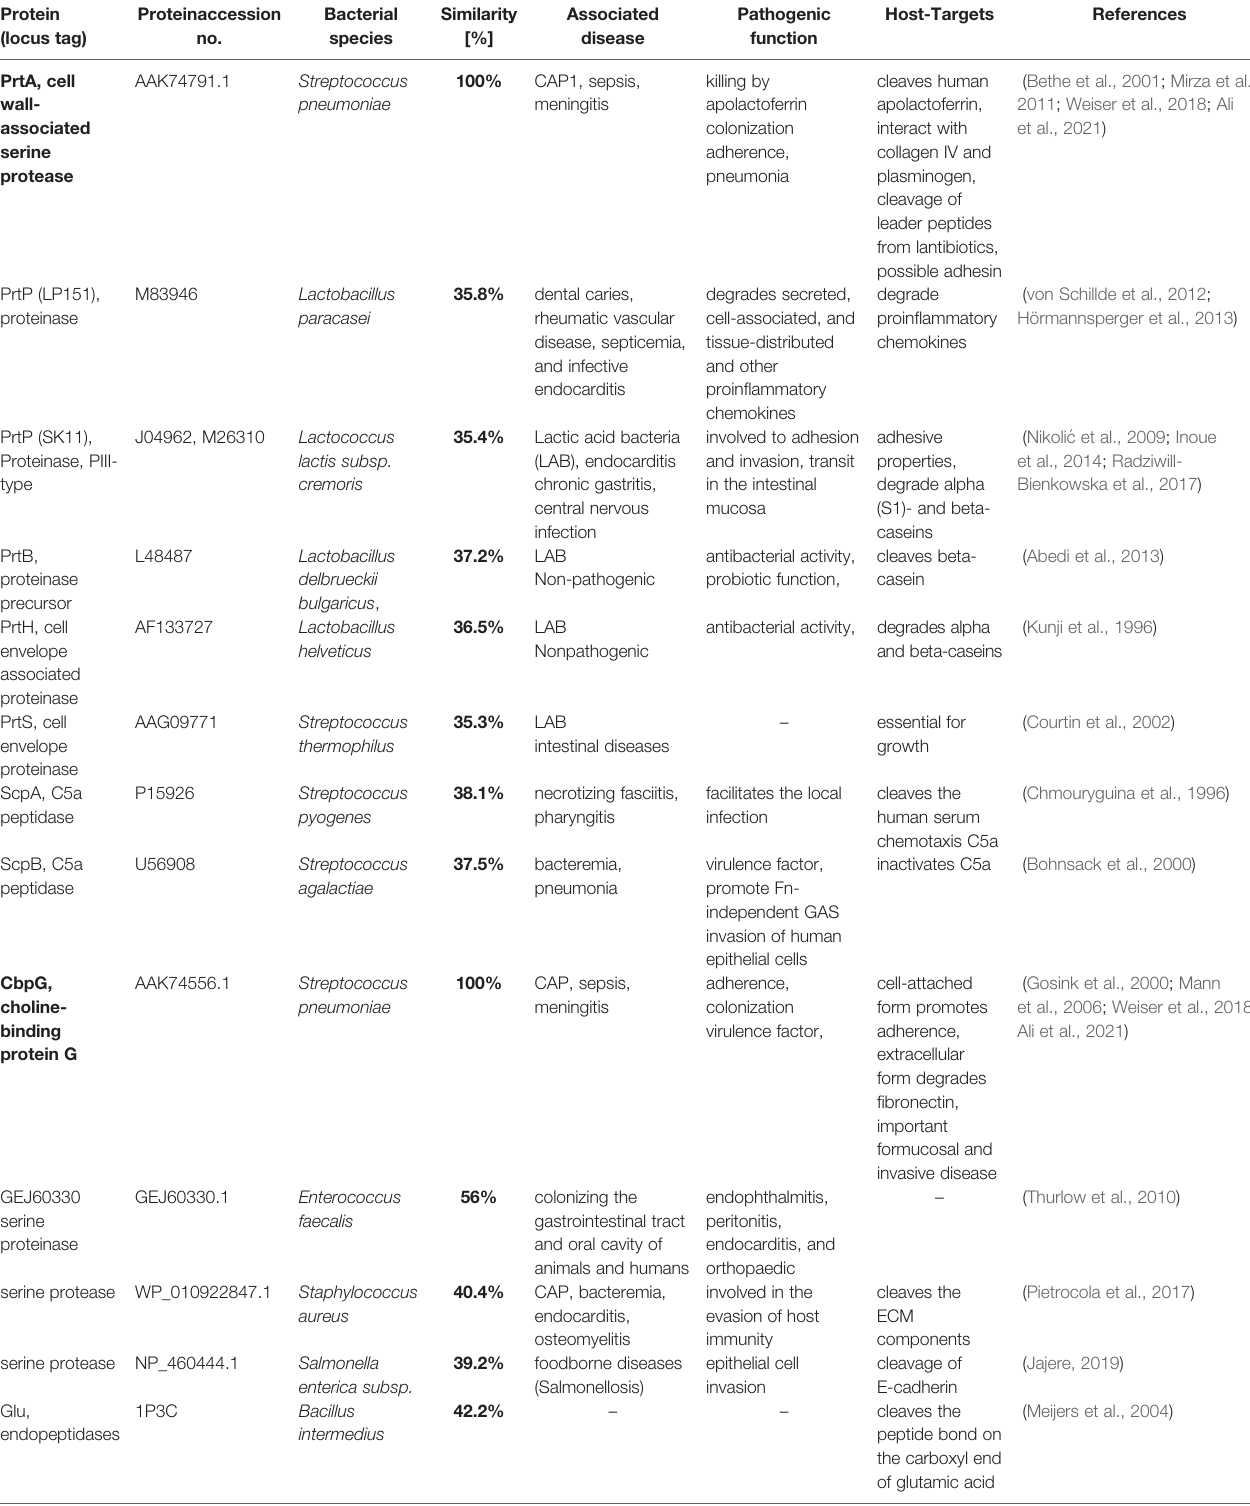
TABLE 2 | Comparison and distribution of pneumococcal serine proteases in other related bacterial species with amino acid sequence similarity and role in pathogenicity, updated from (Ali et al., 2021). Protein (locus